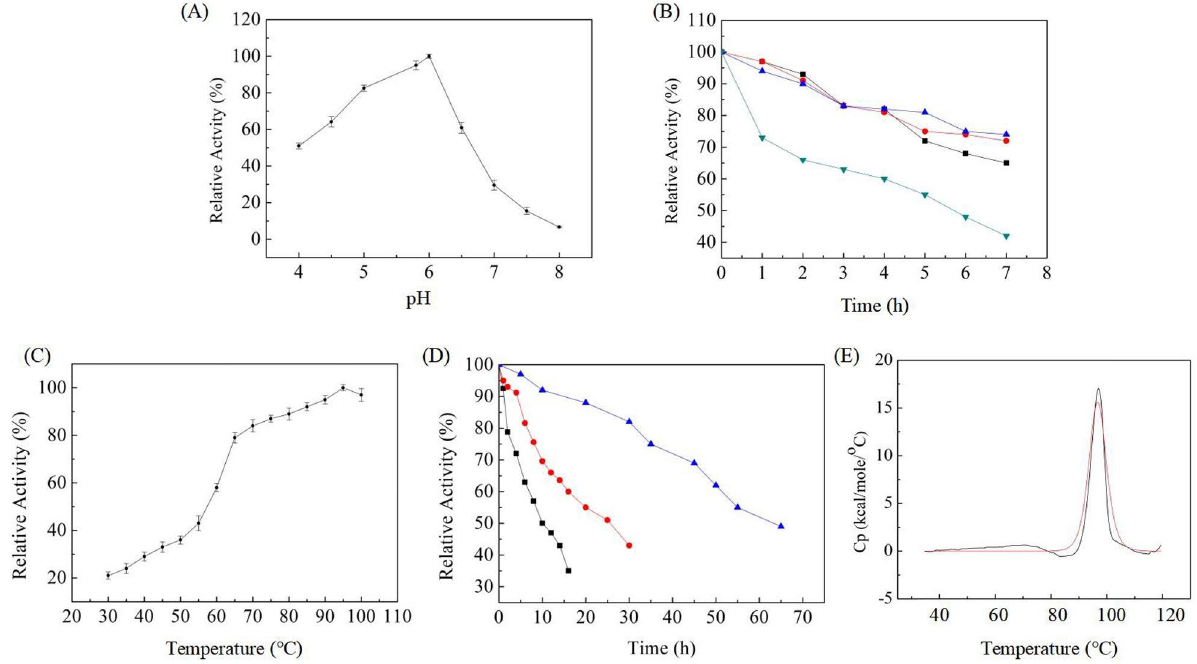
Fig. 4 (A) Effect of pH on enzyme activity. (B) Effect of pH on enzyme stability. The activities were determined by assays with CMC as substrate follow- ing incubation of the enzyme at pH 4 ( ■ ), pH5( ● ), pH 6 ( ▶ ) and pH 7 ( ◀ ) for the indicated times. (C) Effect of temperature on enzyme activity. (D) Effect of temperature on enzyme stability. The activities were determined by assays with CMC as substrate following incubation of the enzyme at 85 °C ( ▲ ), 90 °C ( ● ), and 95 °C ( ■ ) for the indicated times. (E) Differential Scanning Calorimetry (DSC) analysis of BcelFp. The enzyme was concentrated to 1.5 mg/ ml in 50 mM PBS buffer (pH 6.0). The equilibrated enzyme was scanned from 35 to 120 o C at a rate of 2.0 K/min. The enzyme scan was corrected using a buffer–buffer